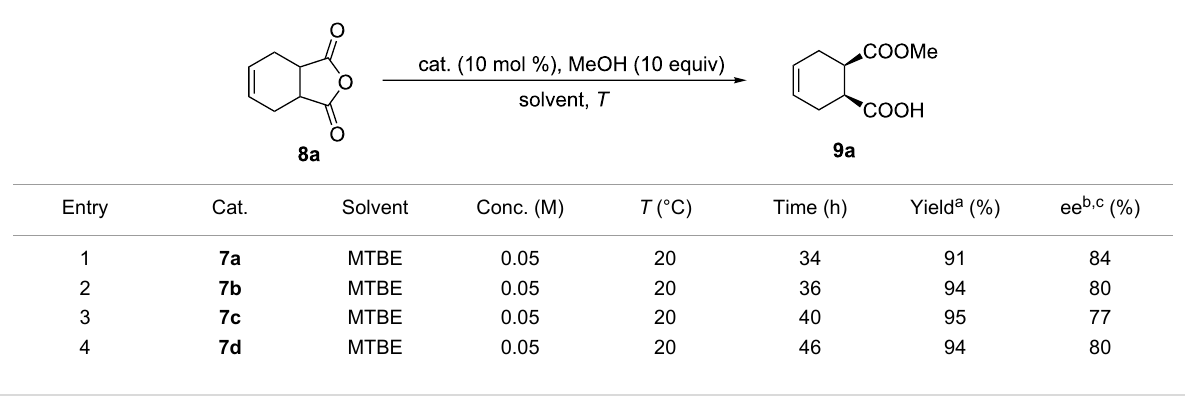
Table 1: Conditions screening for asymmetric methanolysis of meso -cyclic anhydrides.